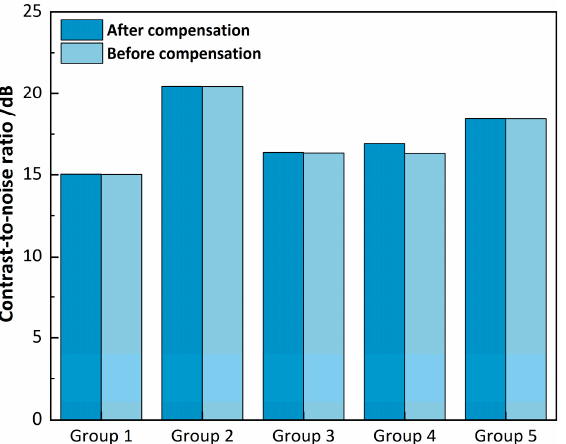
Figure 18. Statistical results of blood flow average CNR detected by the system at different flow rates.